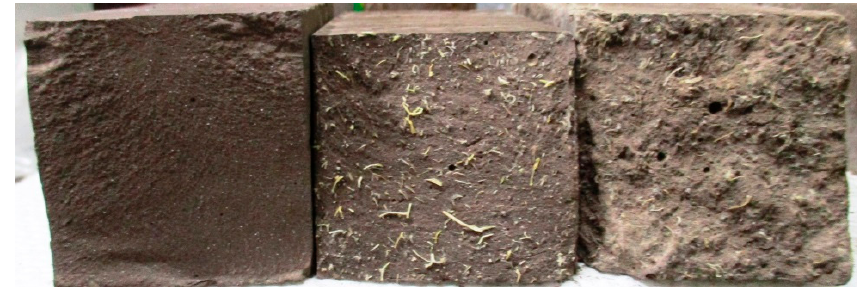
Figure 12. Fracture surface of pristine geopolymer, reinforced with untreated abaca and reinforced with treated abaca.